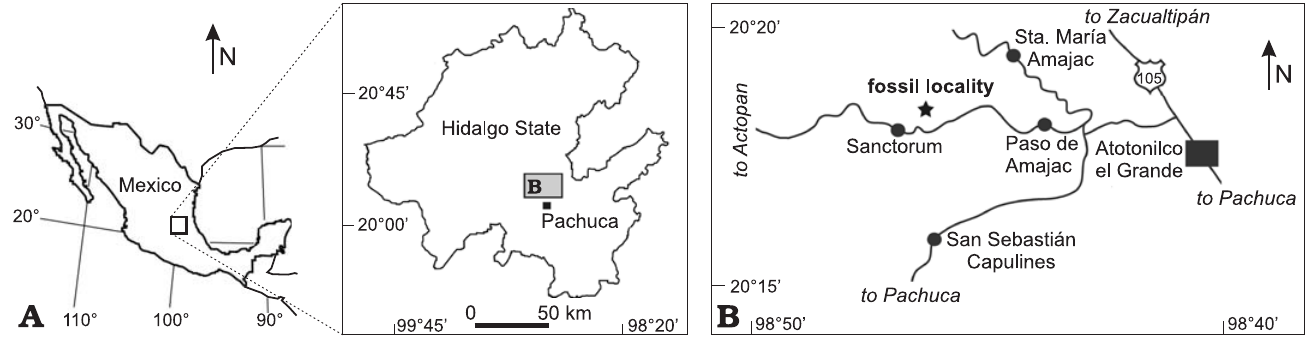
Fig. 1. Location of the studied area in the state of Hidalgo, central Mexico ( A ), map of the Santa María Amajac area ( B